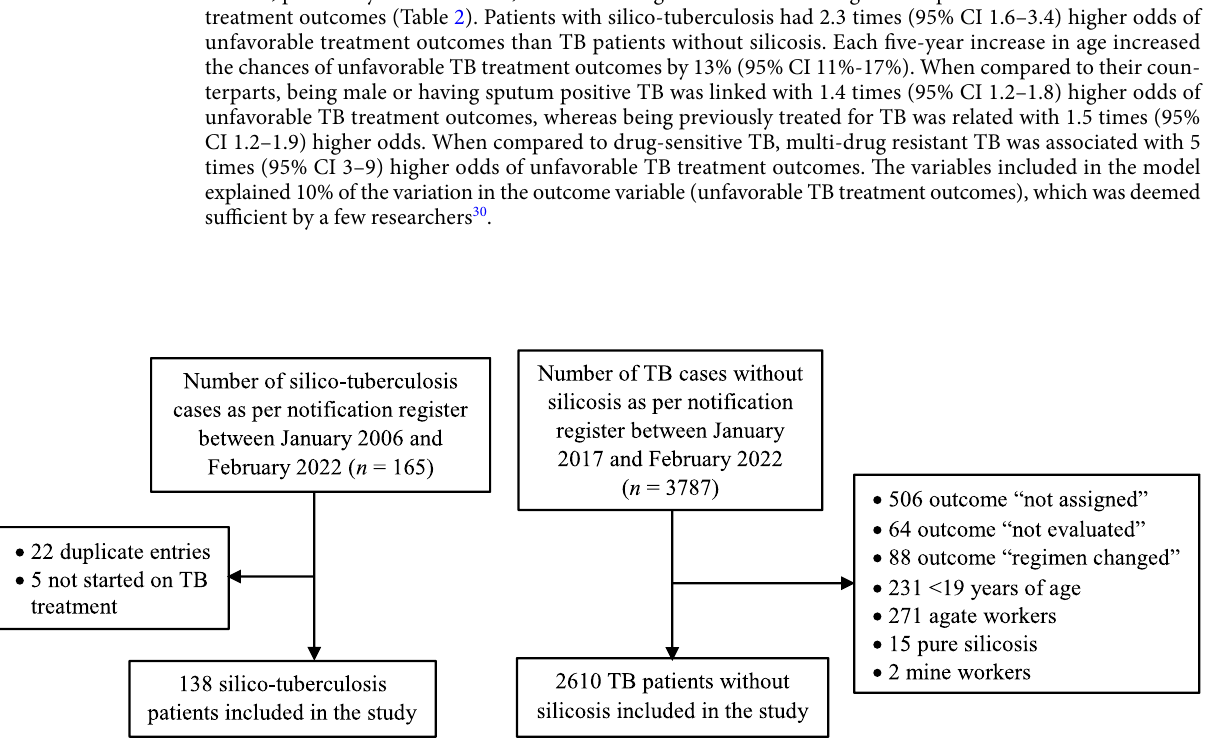
Figure 1. Selection of patients with silico-tuberculosis and patients with TB without silicosis in Khambhat